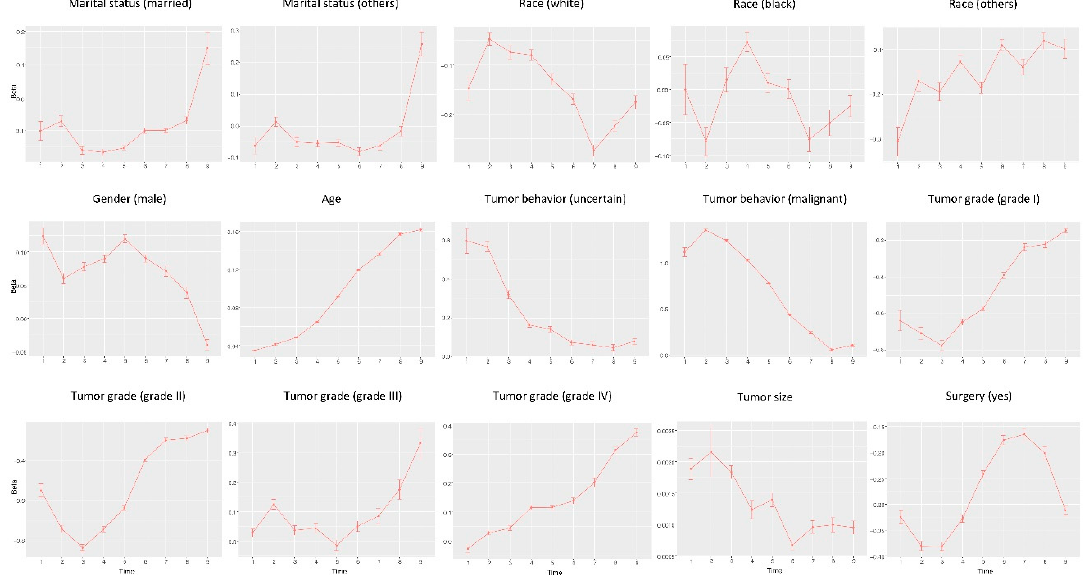
Figure 3. Analysis results for each time interval and by pooling data from all locations: estimated coefficient and 95% confidence interval (vertical bar) for each variable.